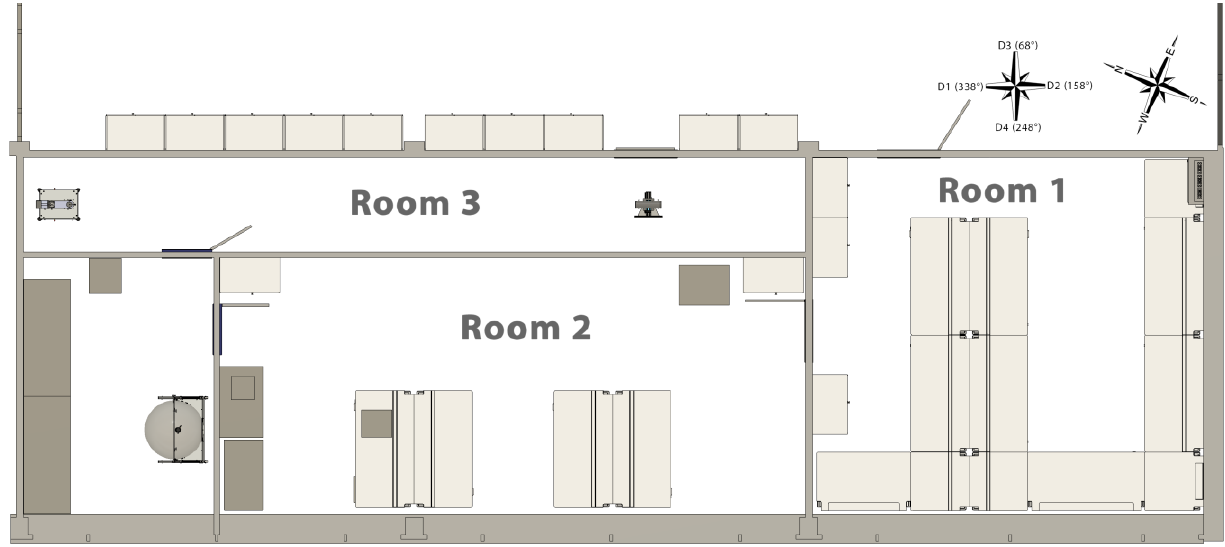
Figure A3. Room 3 (R3) floor plan with test points (P1–P4) and test lines (L1–L4) for the performance of physical activities and spectrum test points (S1–S3).